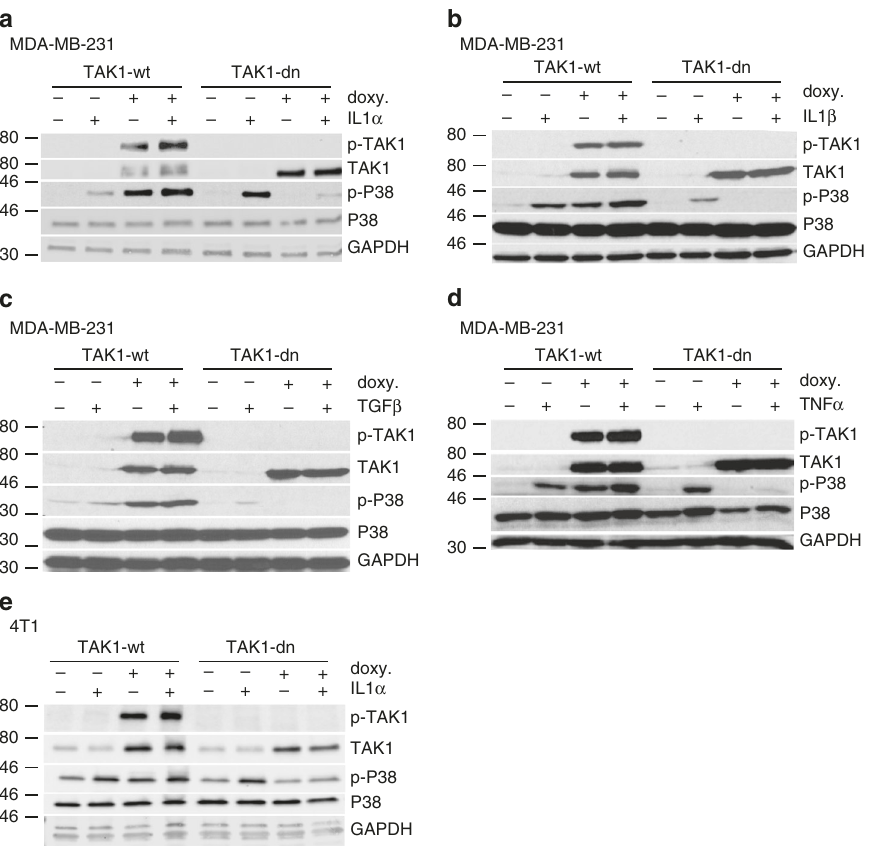
Fig. 3 TAK1 regulates P38 phosphorylation in triple-negative breast cancer cells. a – d P38 phosphorylation in MDA-MB-231 cells overexpressing doxycycline-inducible wild-type TAK1 (TAK1-wt) or dominant-negative TAK1 (dn-TAK1) and treated with IL1 α ( a ), IL1 β ( b ), TGF β ( c ), and TNF α ( d ). e P38 phosphorylation in 4T1 cells overexpressing doxycycline-inducible TAK1-wt or TAK1-dn and treated with IL1 α . In all cases, cells were plated in suspension using serum-free media. Representative examples of three experiments are